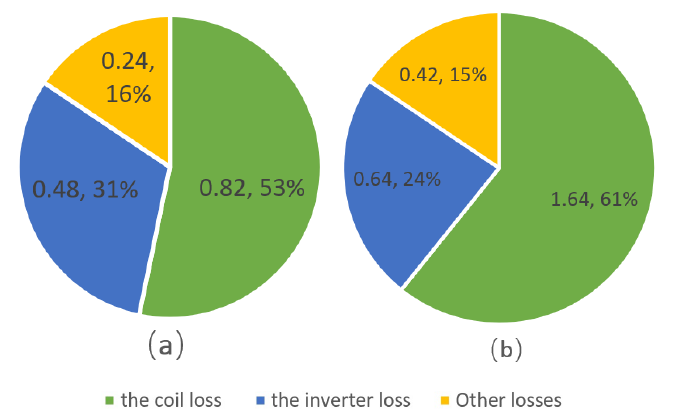
Figure 18. Measured power loss distribution at the 18W output when fully aligned. ( a ) Conventional WPT system loss. ( b ) Proposed WPT system attrition.